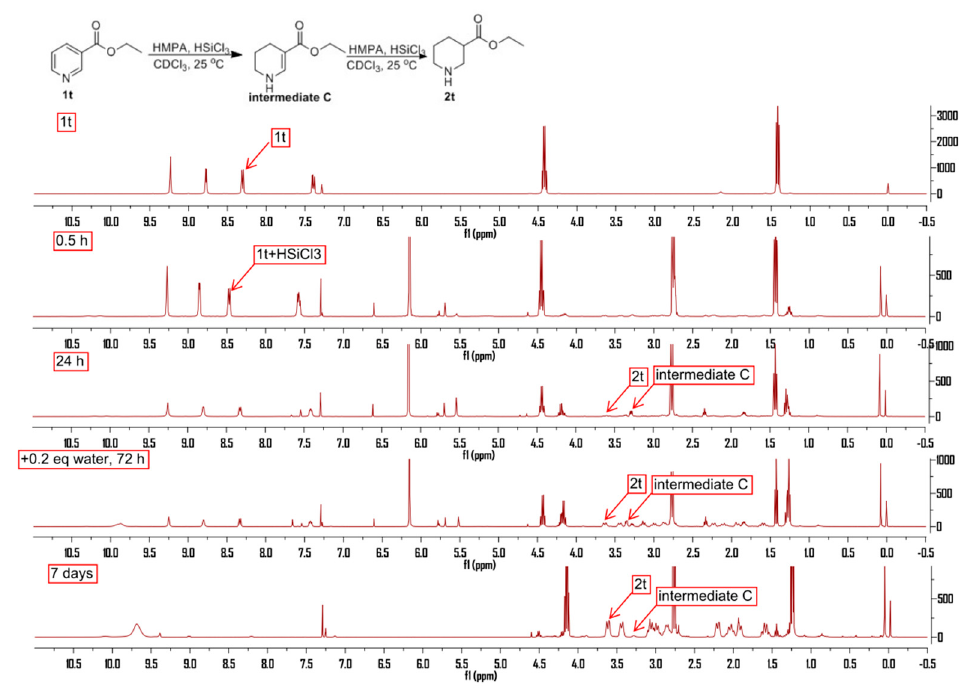
Figure 4. 1 H-NMR spectra for mechanism studies.